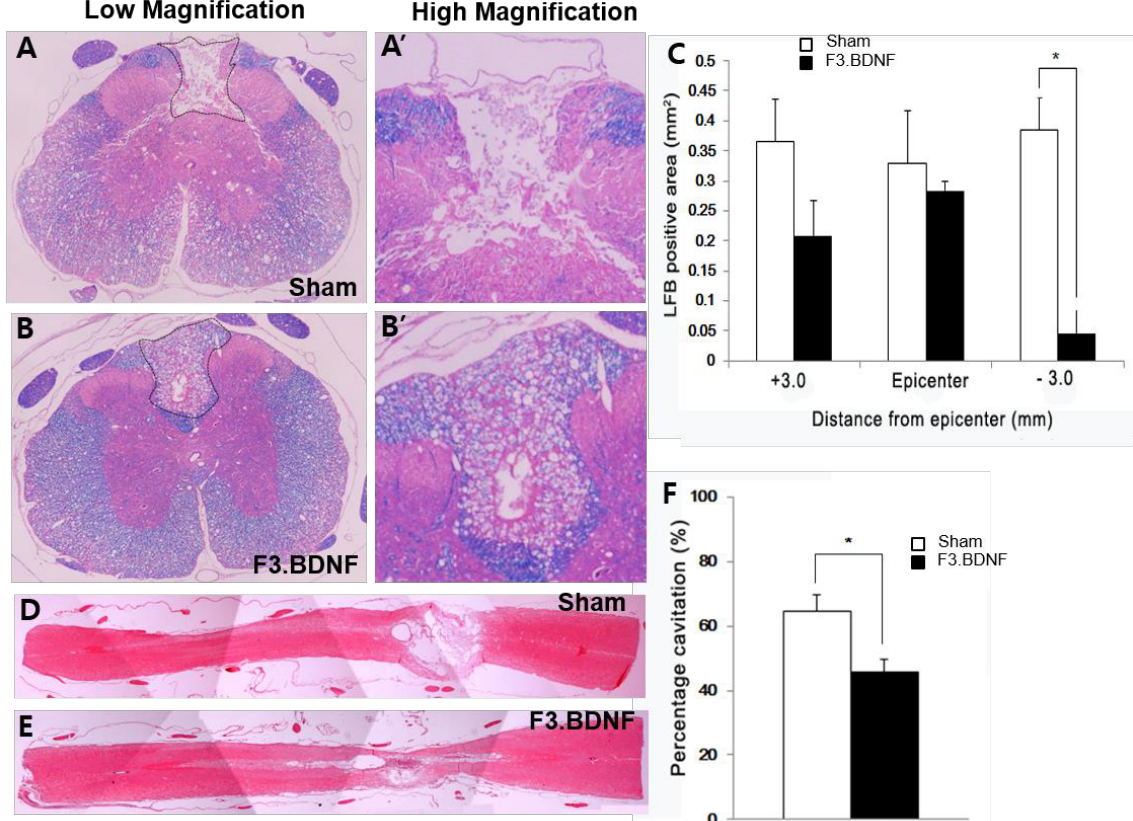
Figure 4. Effects of transplanted F3.BDNF cells within the injured spinal cord. ( A , B ) Representative LFB staining images of a transverse sectioned spinal cord at the lesion epicenter at 10 weeks after transplantation. ( A’ , B’ ) Higher magnification images of the boxed areas in A and B. The nuclear staining was followed by counterstaining with eosin. ( C ) For quantitative analysis of the spinal cord area, LFB-stained axial sections at 0.3 mm caudal and 0.3 mm rostral to the lesion were measured. ( D , E ) Horizontal sections of the spinal cord at the lesion epicenter were significantly reduced in the F3.BDNF groups than the sham group. ( F ) Quantitative analysis of the spinal cord injured area measured in H&E stained horizontal sections through rostral and caudal from lesion epicenter ( n = 3 rats per group, *: p < 0.05) Abbreviations: H&E, hematoxylin-eosin; LFB, luxol fast blue staining.